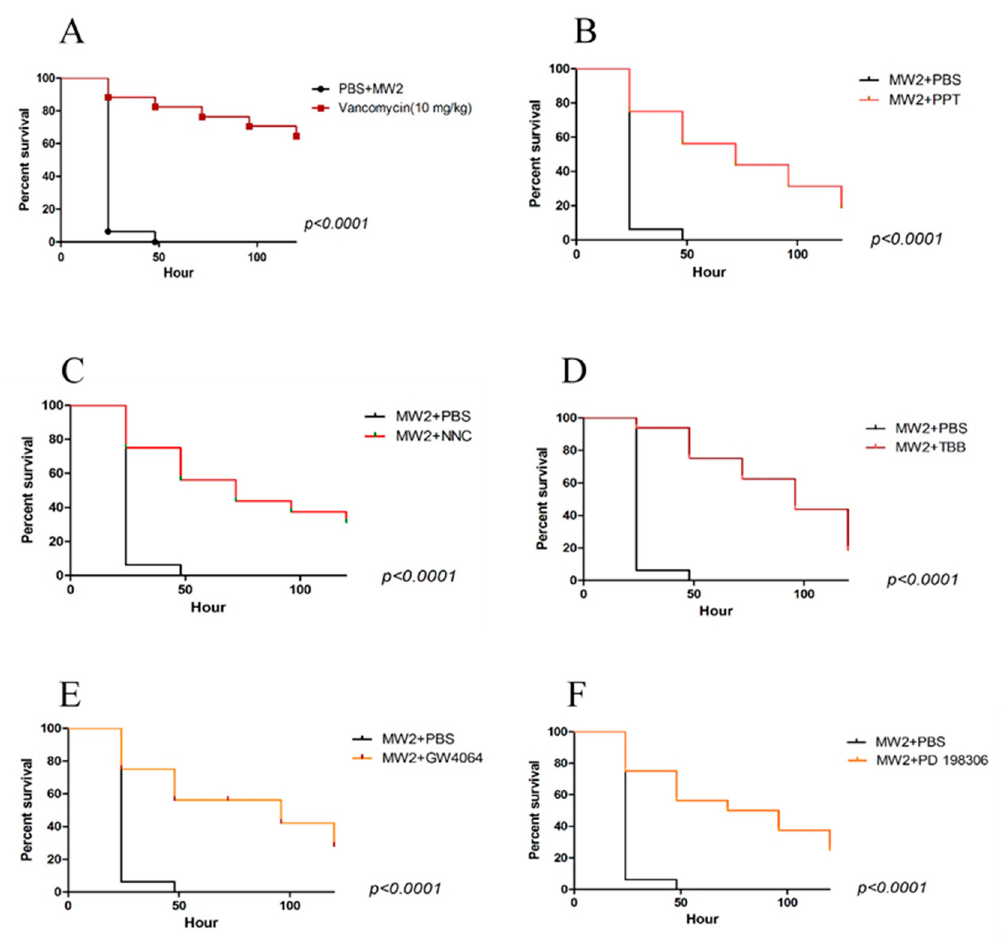
Figure 2. Galleria mellonella larvae infected with S.aureus -MW2 were treated with vancomycin (10 mg/kg) ( A ) or one of the five compounds ( B – F , 10 mg/kg) and survival was monitored for 120 hr. Statistical analyses (Kaplan–Meier survival analysis with log-rank test) were conducted using GraphPad Prism version 8 (GraphPad Software, La Jolla, CA,